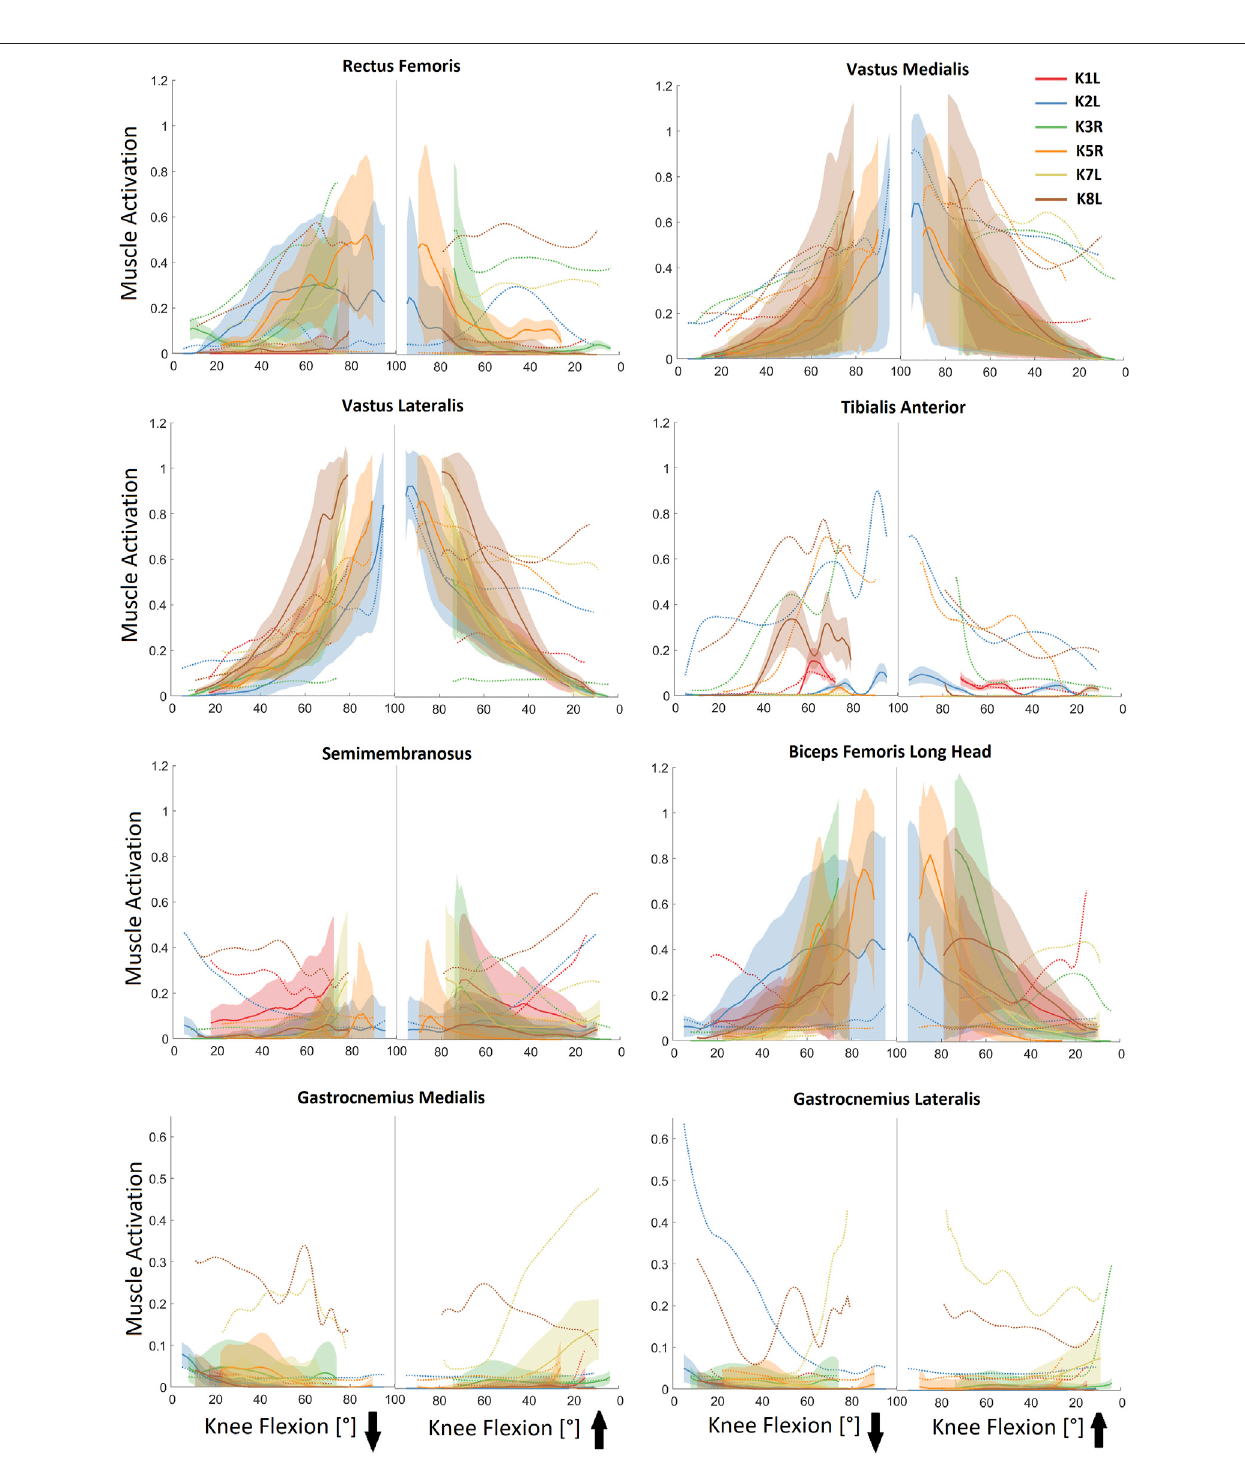
FIGURE 2 | In vivo measured EMG (dotted lines) vs. predicted muscle activation levels for selected lower limb muscles during the studied squat trials. Solid lines represent average (baseline) activation patterns obtained from baseline models, whereas shaded areas display 5th – 95th percentile range of the muscle activations obtained from general Monte Carlo simulations. The downward and upward arrows represent the descending and ascending phases of the squat activity.